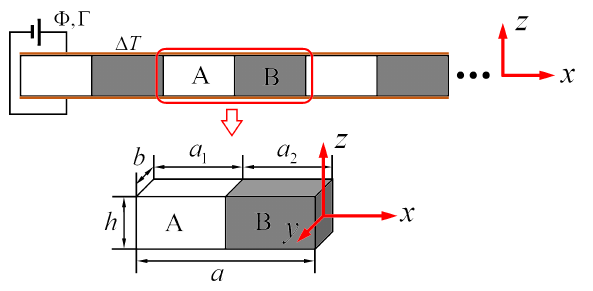
Figure 1. Schematic of a MEE-PC